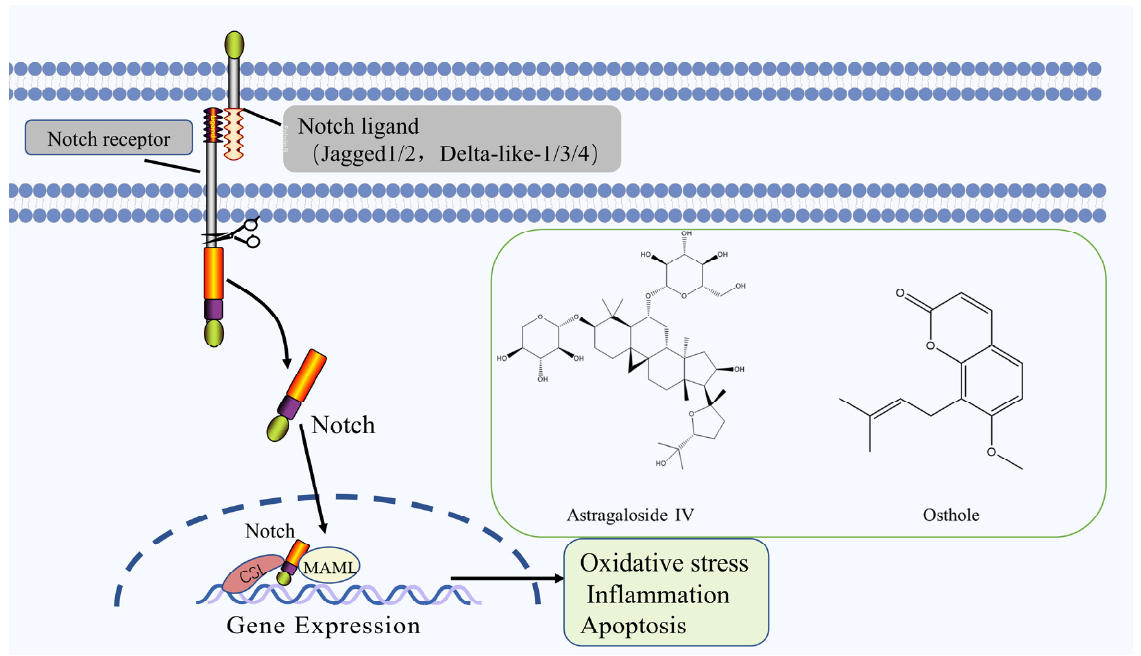
Figure 4. Notch signaling pathway and the chemical structure of natural compounds.